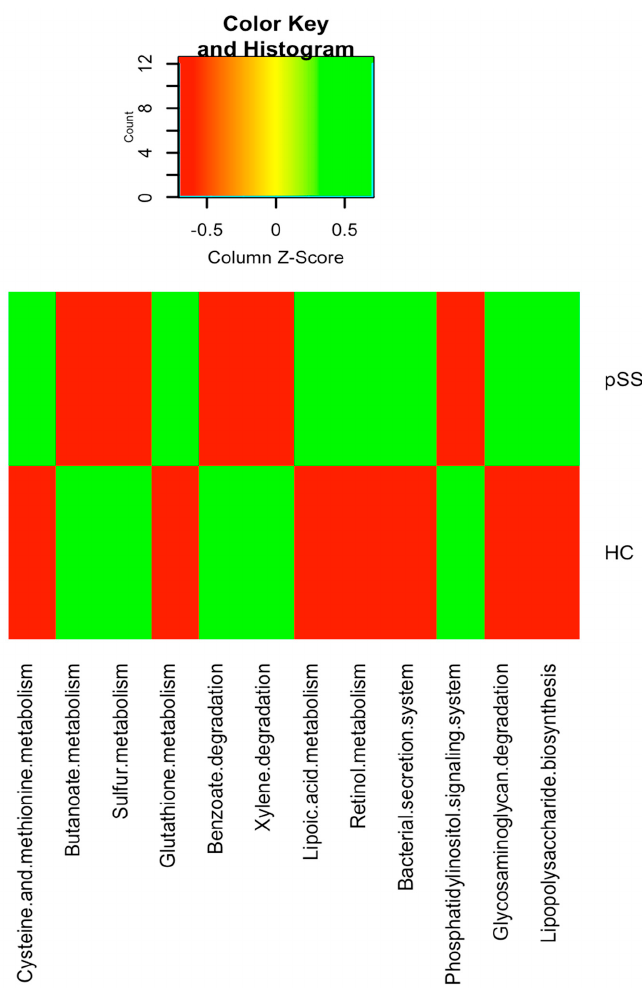
Figure 6. Heatmap of bacterial gene functional predictions using the Phylogenetic Investigation of Communities by Reconstruction of Unobserved States (PICRUSt) algorithm from fecal samples from primary Sjögren’s syndrome (pSS) patients and healthy controls (HC).